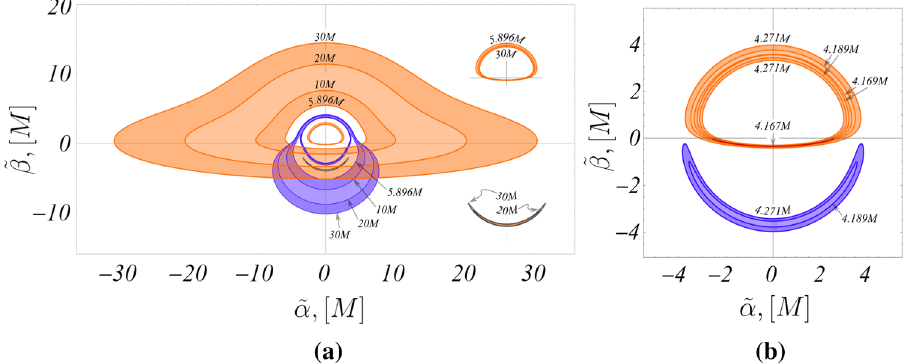
Fig. 5 Opticalappearanceoftheouter(left)andtheinner(right)accre- tion disks around the strongly naked Janis–Newman–Winicour singu- larity with γ = 0 . 48. The direct image is in orange, the secondary image with k = 1 is in blue, while the higher order images are pre-